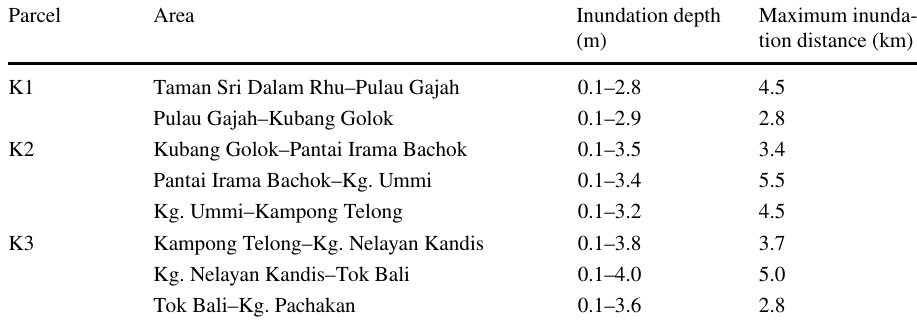
Table 4 Inundation depths and inundation distances in Kelantan at Mw